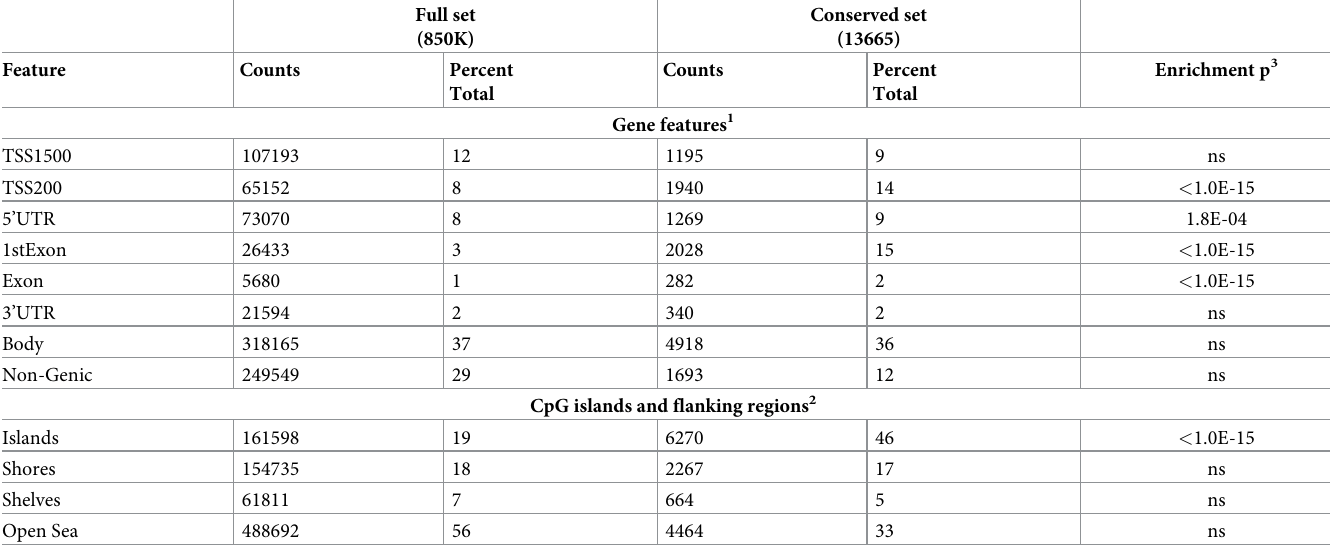
Table 2. Genomic features of CpGs and enrichment in conserved